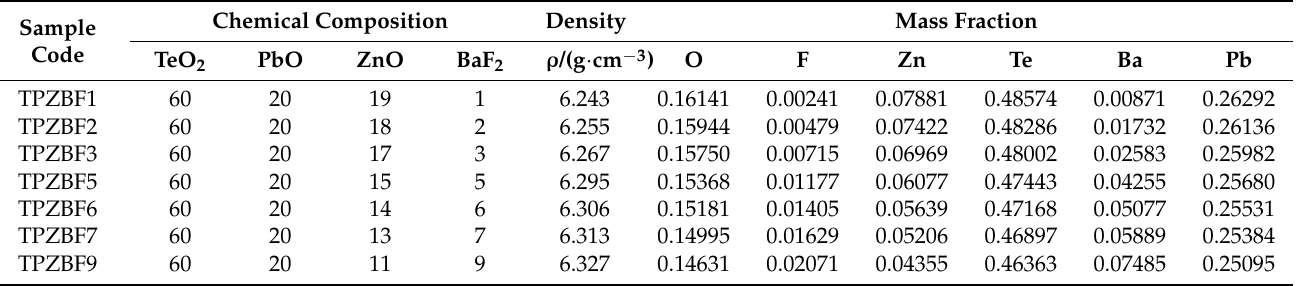
Table 1. Compositions and density of TPZBF series